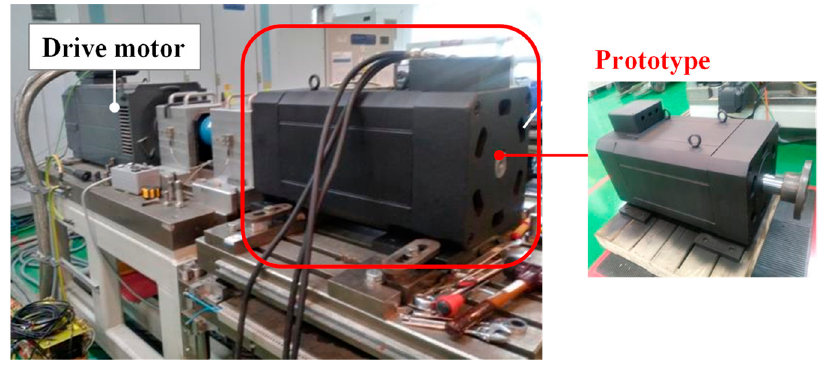
Figure 19. Measurement equipment.